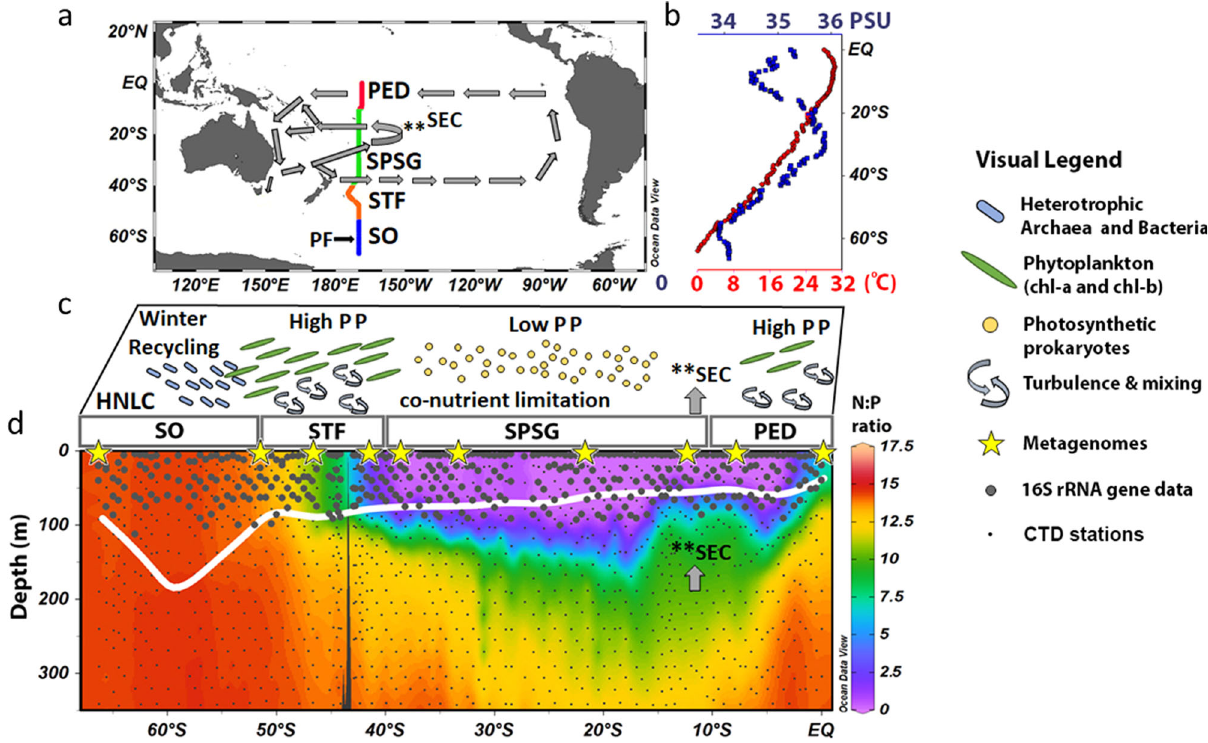
Fig. 1 Oceanographic transect with abiotic water column data and conceptual mechanistic understanding of the microbial biogeography. a The GO- SHIP P15S transect along the 170 o W meridian in the South Paci fi c Ocean. Gray arrows indicate the South Equatorial Current (SEC) within the upper ocean, and include a westward returning branch between 20° and 10° S (denoted by **SEC 69, 70 ). The oceanographic provinces 54 are color coded: the Southern Ocean (SO; blue), the Subtropical Frontal Zone (STF; orange), the South Paci fi c Subtropical Gyre Province (SPSG; green), the Paci fi c Equatorial Divergence Province (PED; red), the Polar Front (PF) is in addition highlighted by a black arrow. b Pro fi les for SST (red; bottom x -axis) and salinity (blue; top x -axis). c Conceptual mechanistic understanding of relative changes in the functional prokaryotic and microbial-eukaryotic biogeography. Blue rods represent heterotrophic archaea and bacteria, which recycle in winter the organic matter produced in the summer and autumn months in the high nutrient low chlorophyll (HNLC) region of the SO. High primary productivity (PP) driven by phytoplankton rich in chlorophyll (green discs) is expected in the STF due to turbulence and mixing (curved arrows). The oligotrophic SPSG is characterized by low PP and nutrient co-limitation, as well as by higher abundances of photosynthetic prokaryotes (yellow circles). The westward returning branch of the SEC is indicated with the gray arrow in c , d and can be the source of the increase in N:P ratios at 100 m depth. Equatorial upwelling and mixing in the PED results in an increase of the N:P ratio at the surface and, thus, in increased PP and chlorophyll concentrations. d Latitudinal plot of N:P ratios from the surface to 350 m depth. The thick white line represents the MLD; 16S rRNA sampling stations are shown in large gray circles; shotgun metagenome samples are represented by yellow stars; and CTD stations appear as small gray vitamin biosynthesis pathways. Although the correlation coef fi - cients for CO 2 - fi xation pathways were the weakest, these PICRUSt2 predicted pathways were positively correlated with PP (Fig. 2f). Similar to the work of Agrawal et al. 15 , who validated their PICRUSt2 predictions with qPCR data, we herein show that